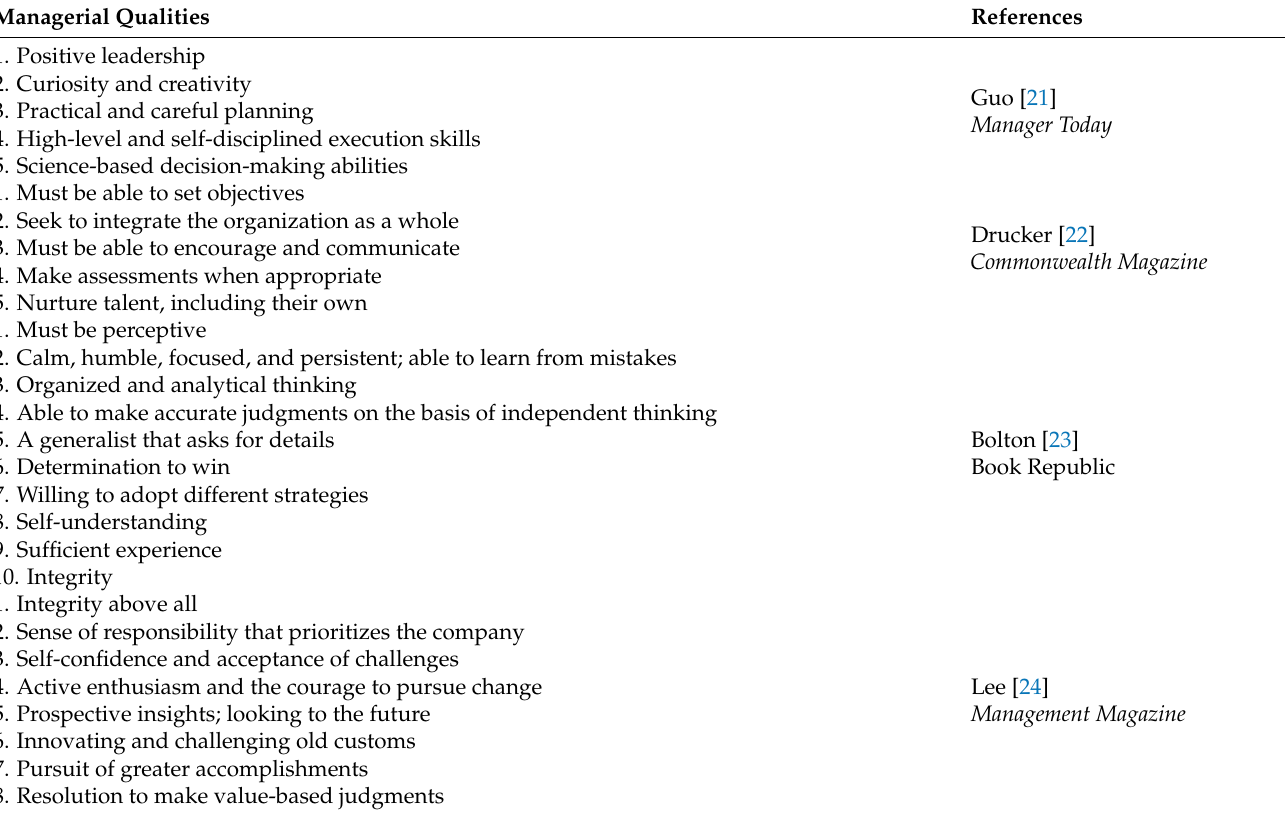
Table 2. Managerial